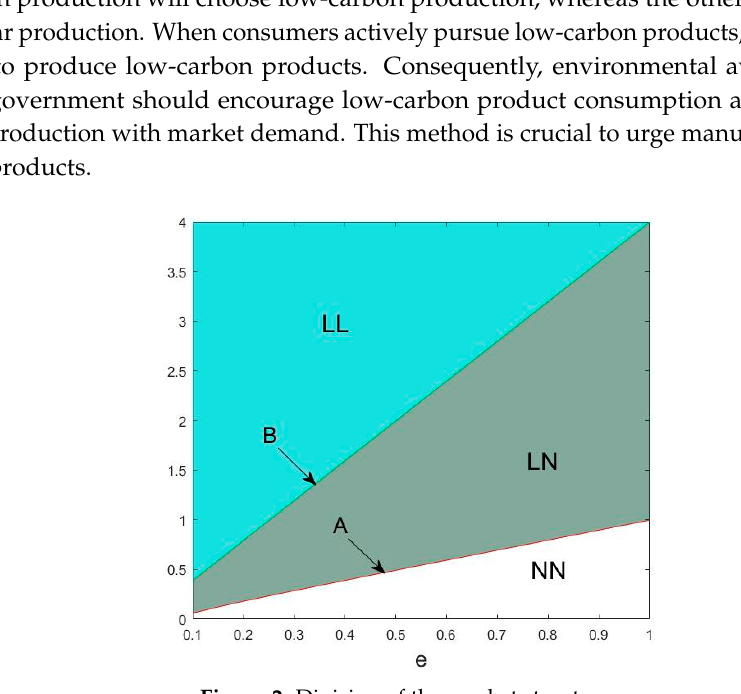
Figure 2. Division of the market structure.